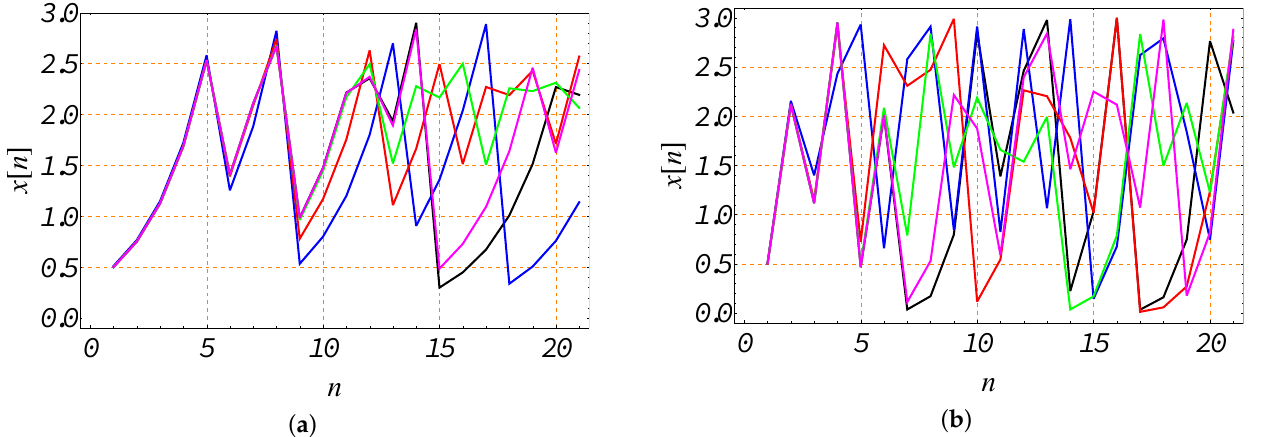
Figure 7. Sequences produced by both chaotic maps when x 0 = 0.5, α = 3.0, and µ = 2, with (cid:101) 0 = 0.0 (black), (cid:101) 0 = 1 × 10 − 2 (blue), (cid:101) 0 = 1 × 10 − 3 (red), (cid:101) 0 = 1 × 10 − 4 (green), and (cid:101) 0 = 1 × 10 − 5 (magenta), ( a ) STM and ( b )